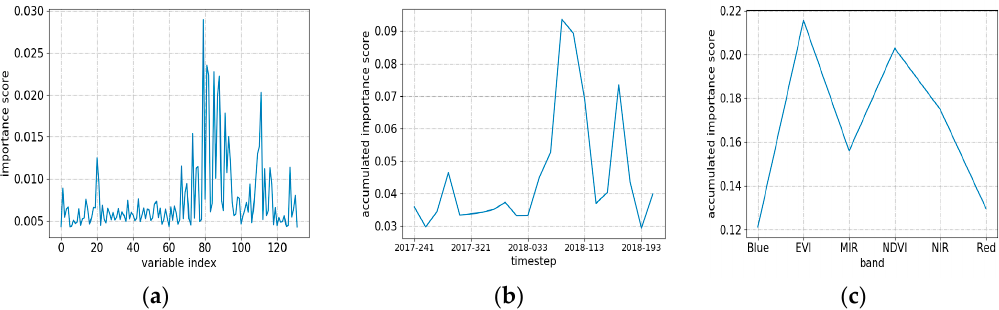
Figure 9. ( a ) Importance scores of 132 variables with the hierarchy indexed by timestep and band, ( b ) Accumulated importance score per timestep, ( c ) Accumulated importance score per band.